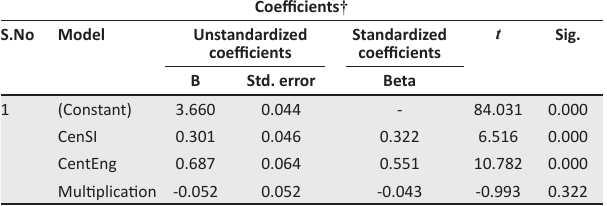
TABLE 6c: Moderation